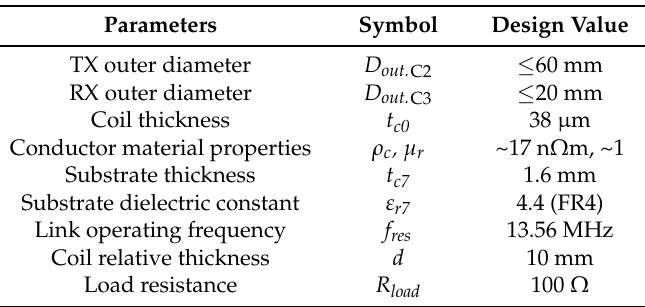
Table 1. Design Constraints.